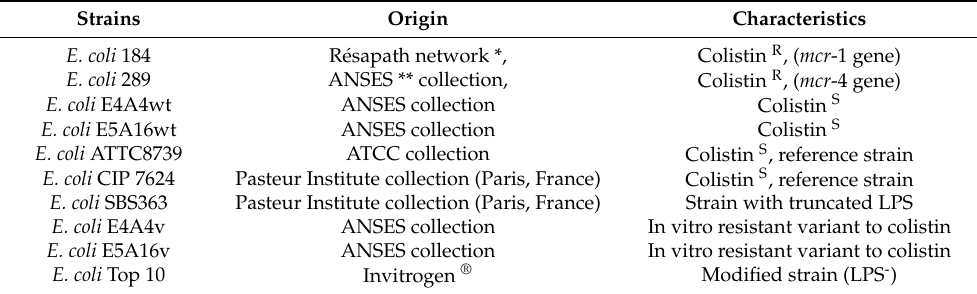
Table 7. E. coli strains used in this